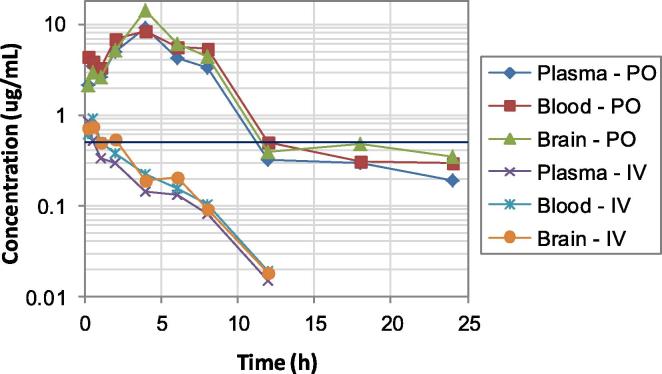
Time vs concentration curves for 12, following administration to male CD-1 mice (at 50 mg/kg po and 1.1 mg/kg iv). The horizontal line represents the MIC for complete inhibition of visible parasite growth in vitro.